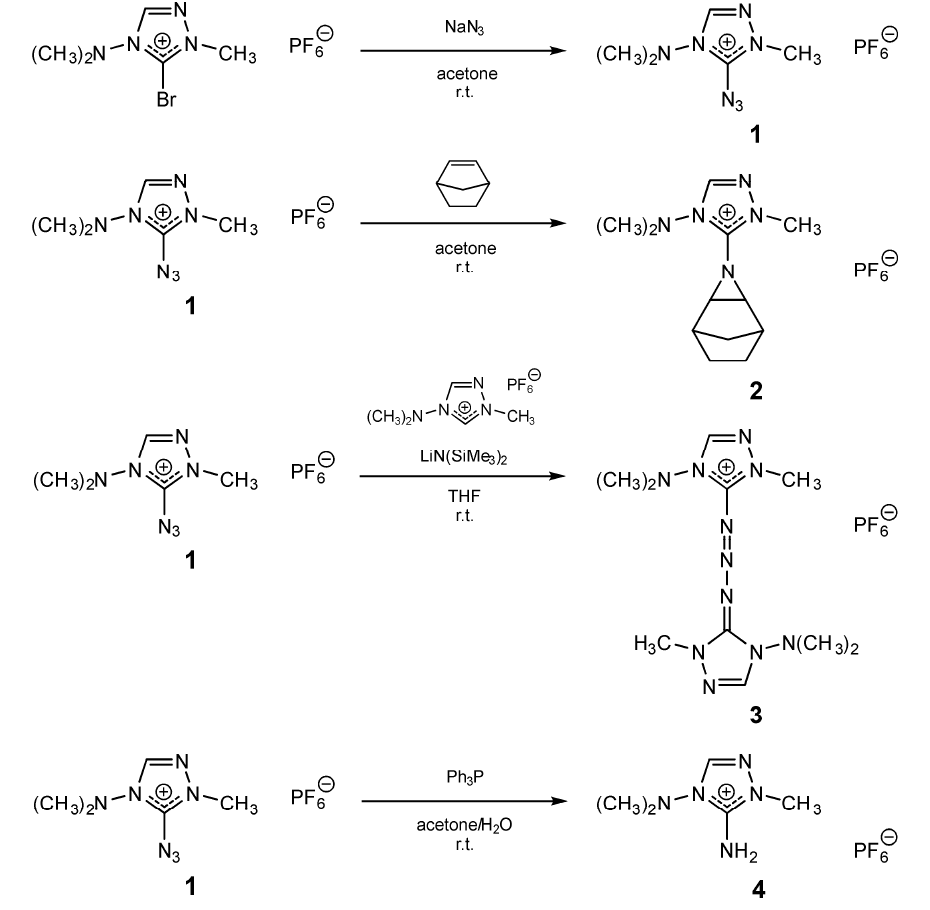
Figure 1. Reagents and conditions: ( a ) NaN 3 , acetone, rt; ( b ) bicyclo[2.2.1]hept-2-ene, acetone, rt; ( c ) 4-(dimethylamino)-1-methyl-1,2,4-triazolium PF 6 , LiN(SiMe 3 ) 2 , THF, rt; ( d ) Ph 3 P, acetone, H 2 O, rt.